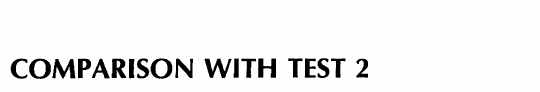
gage should be the same as the time of arrival for the free-field stress gage at the same range. This is true in the analysis, but not in the